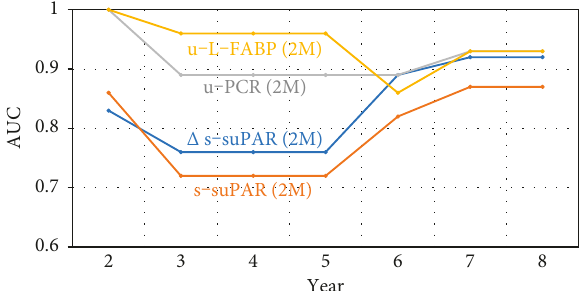
Figure 1: Time-dependent accuracy of each clinical parameter for predicting 40% reduction in the eGFR. suPAR, soluble urokinase receptor; s-, serum; u-, urinary; L-FABP, liver-type fatty acid-binding protein; PCR, protein-to-creatinine ratio; ROC, receiver operating characteristic; AUC, the area under the ROC curve. Predictive ac- curacy for the cumulative incidence of 40% reduction in the eGFR by X years after starting immunosuppressive therapy using time-de- pendent ROC curve analysis ( X � 2, 3, 4, 5, 6, 7, and